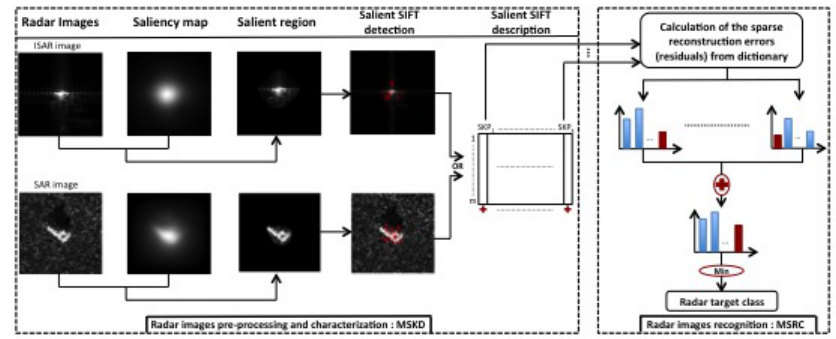
Figure 1. Flowchart of the proposed ATR approach: